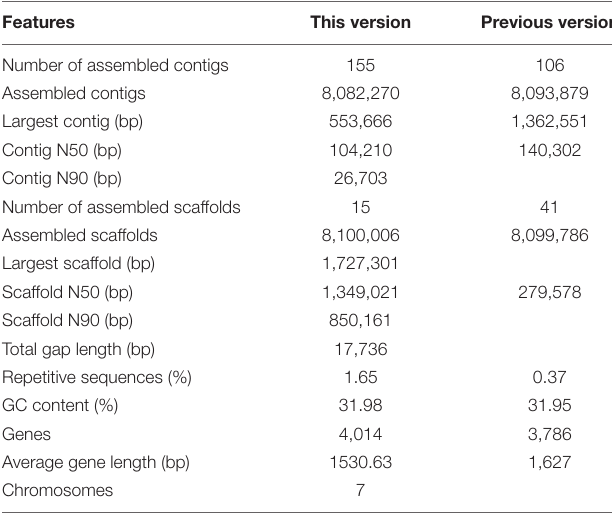
TABLE 1 | Statistics of the Kloeckera apiculata draft genome assembly assisted by Hi-C